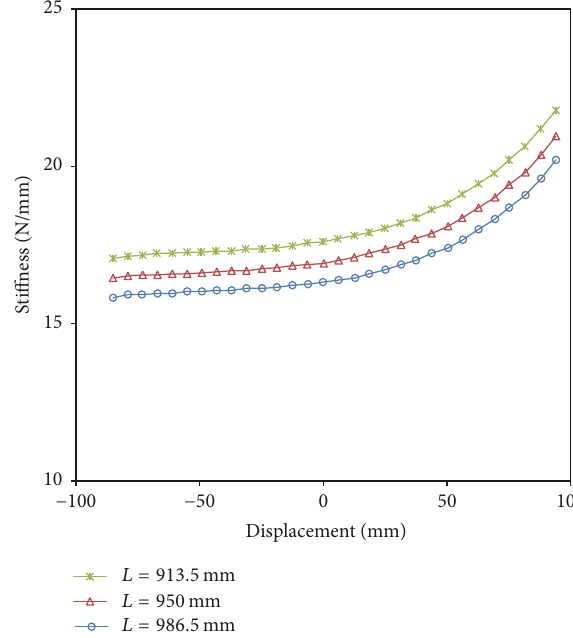
Figure 7: Stiffness curve of the suspension with variable length.